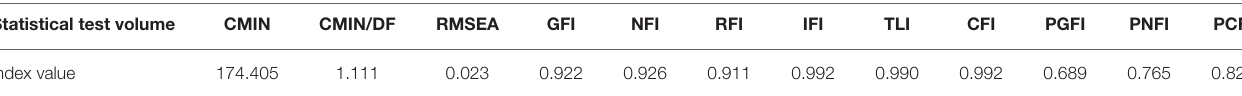
TABLE 3 | Overall evaluation index of structural equation model.